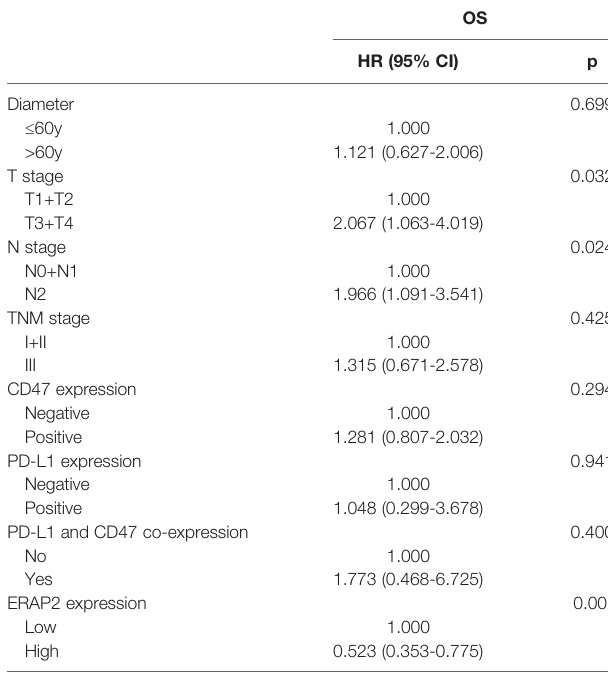
TABLE 3 | Multivariate Cox Regression of Prognostic Factors in SqCLC.